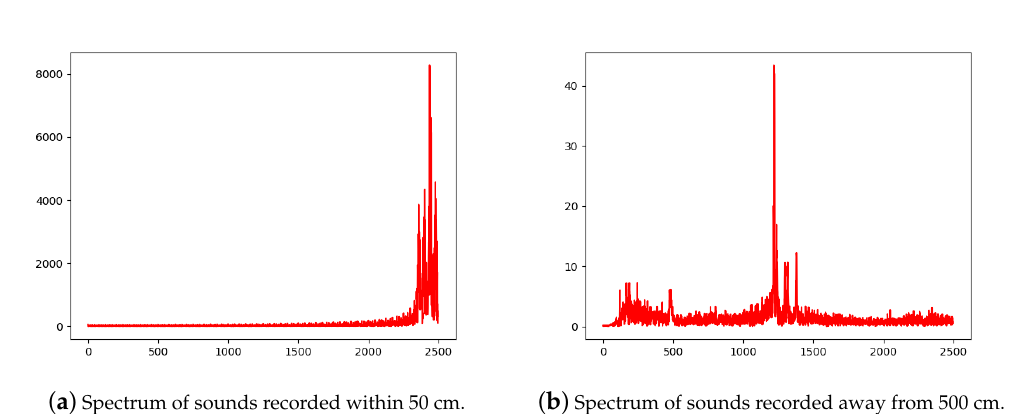
Figure 5. ( a ) The spectrum of sounds recorded very close to the device; and ( b ) the spectrum of sounds recorded a bit far from the device.